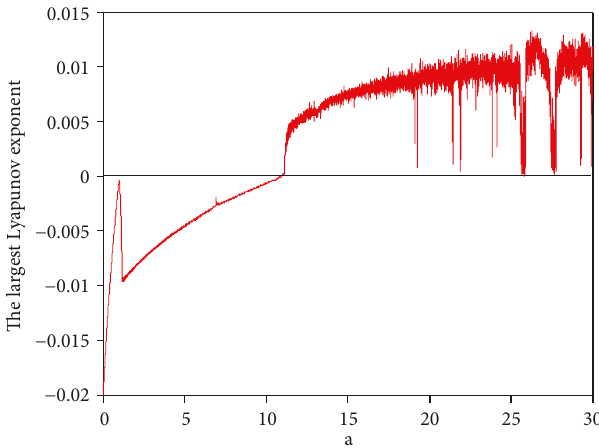
Figure 2: The largest Lyapunov exponent of system (2) with b , δ = 3, 0 02 and a ∈ 0, 30 .